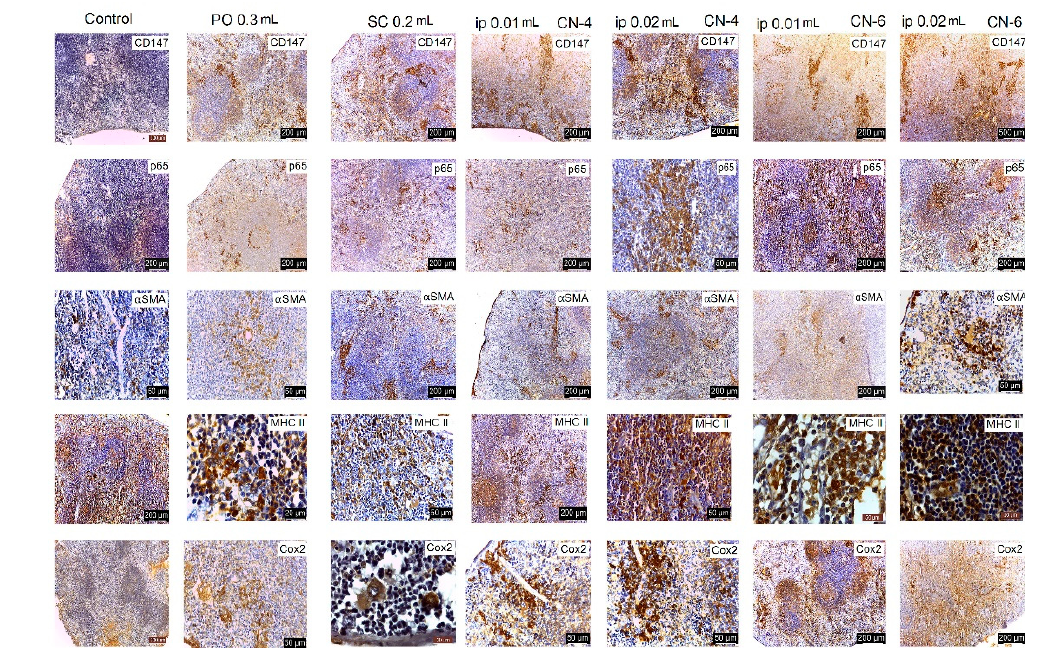
Figure 17. IHC labelling in the lung.